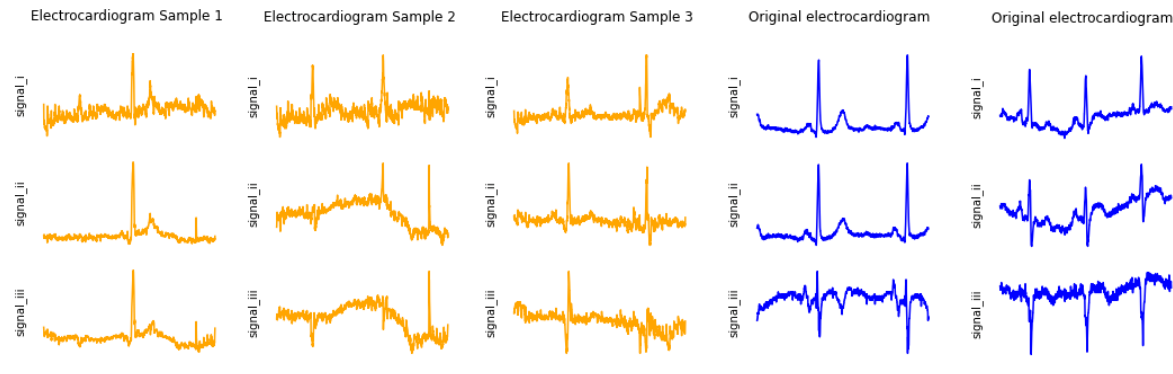
Figure 17. ( Left ) Three generated electrocardiograms after 200 epoch using the RGB data arrangement for three channles. ( Right ) Two original samples from the Cardiogram